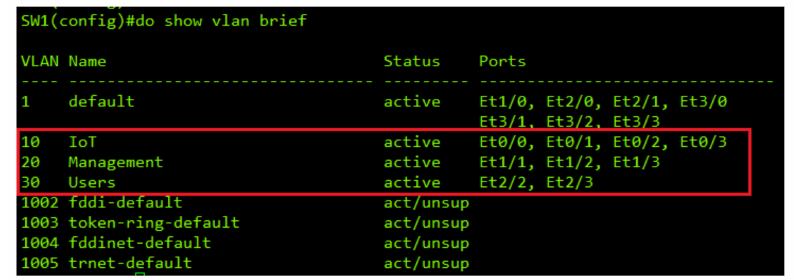
Figure 12. VLANs created for hardening